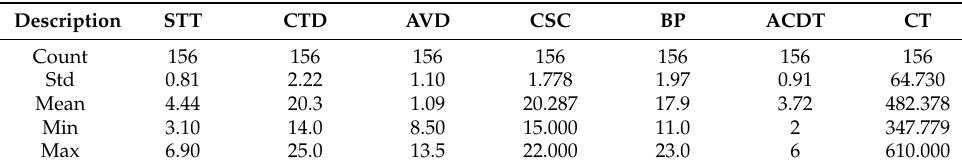
Table 1. Statistical description of the key performance indicators for Douala